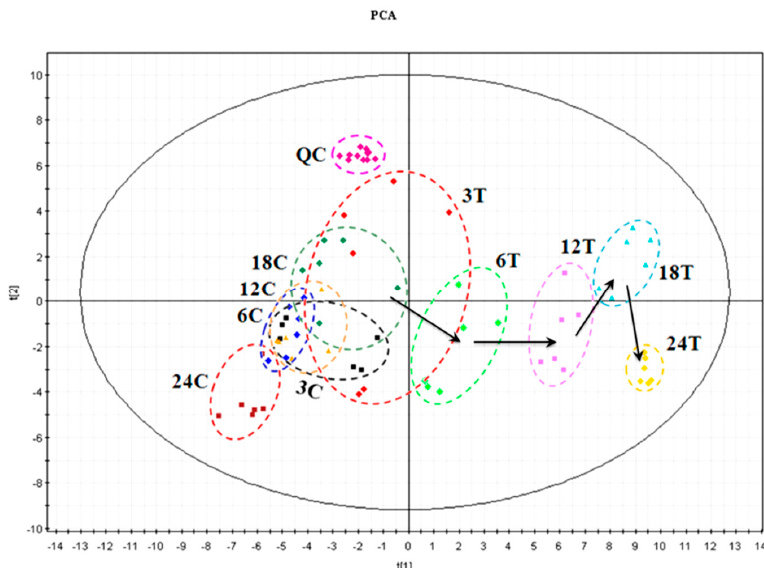
Figure 2. Principal component analysis (PCA) scores plot derived from UHPLC-MS data both in positive mode and negative mode for extracts obtained from the control (C) and PSF-treated (T) S. miltiorrhiza hairy roots collected 3, 6, 12, 18 and 24 d post-elicitation. 3C: black squares, 6C: blue rhombus, 12C: yellow triangles, 18C: olive rhombus, 24C: wine squares; 3T: red rhombus, 6T: green rhombus, 12T: pink squares, 18T: cyan triangles, 24T: yellow rhombus. Table 1. Parameters of PCA and partial least squares discriminant analysis (PLS-DA) models by the control and treated